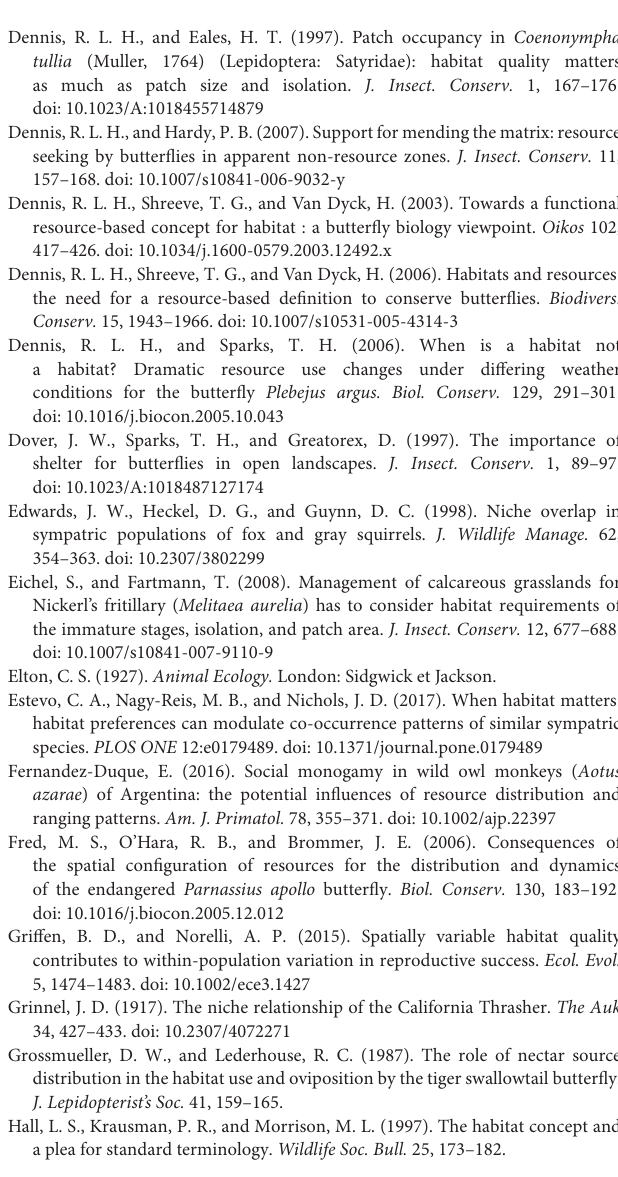
resources variables were highly correlated (see section Methods), some were discarded from the analysis. Supplementary Figure 2 | Additional information on vegetation samples. (A) Schematic representation of a vegetation sample, considering two plant species (black dot and star). The 1 m 2 sample was divided in a 5 ∗ 5 grid, forming 25 squares (each 20 ∗ 20cm) to estimate the abundance of each plant species on the basis of their presence in each square, i.e., on a zero to 25 scale. In this example, abundance of the black dot species equals 11 and abundance of the black star species equals 5. (B) The number of vegetation samples collected (Y-axis) in sites hosting B. eunomia populations increased with the site host plant area (X-axis). (C) The number of vegetation samples collected (Y-axis) in sites hosting B. aquilonaris populations increased with the site host plant area (X-axis). Note that the relationship is not perfectly linear due to the heterogeneity in the vegetation of within each site (not illustrated here). (D–F) Results of the PCAs performed with the vegetation samples collected in each zone and